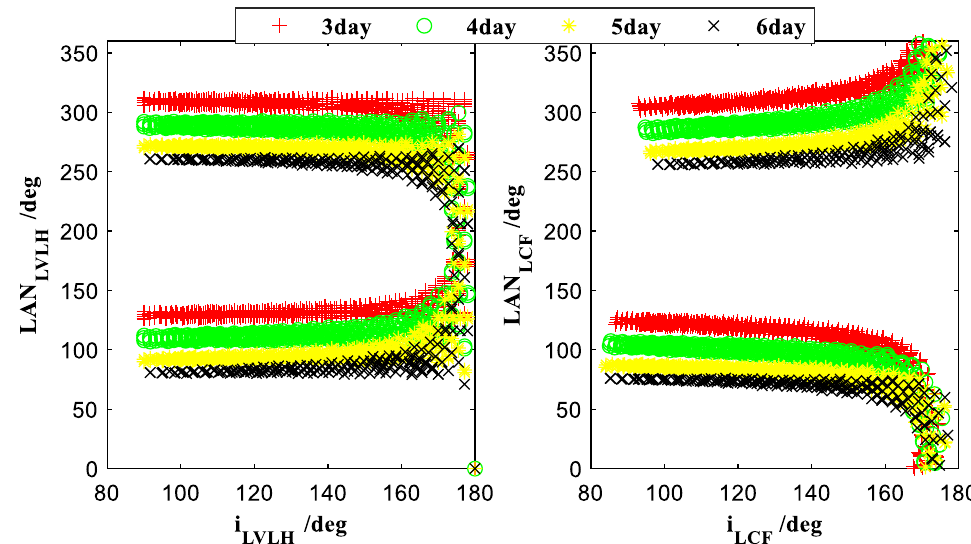
Fig. 10 The inclination and LAN in LVLH frame and LCF frame with different trans‑lunar